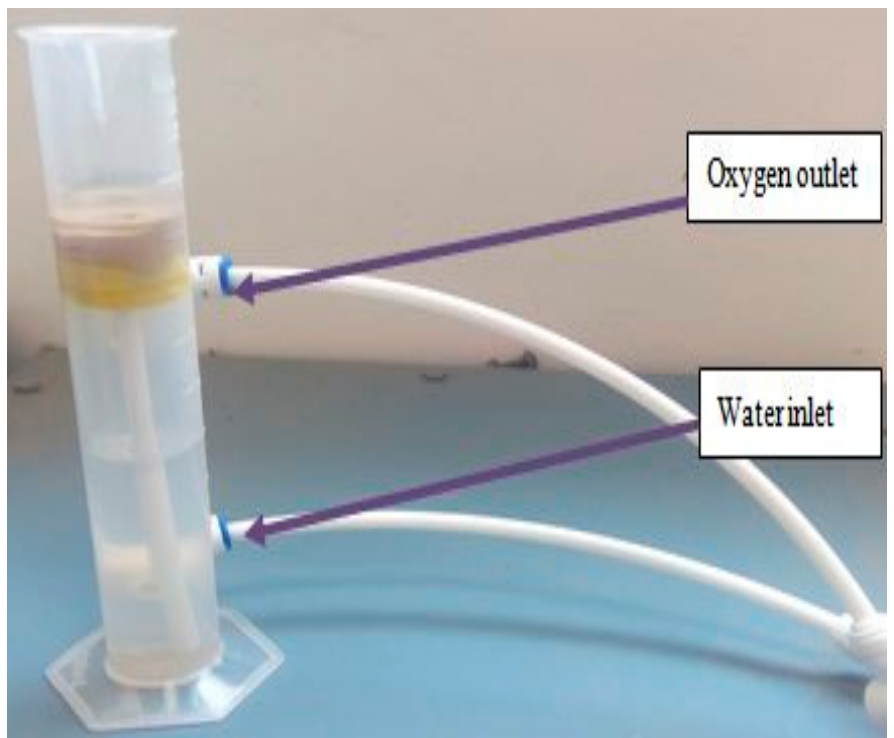
Figure 9. Oxygen side gas collection cylinder of the modified unitized regenerative fuel cell URFC.